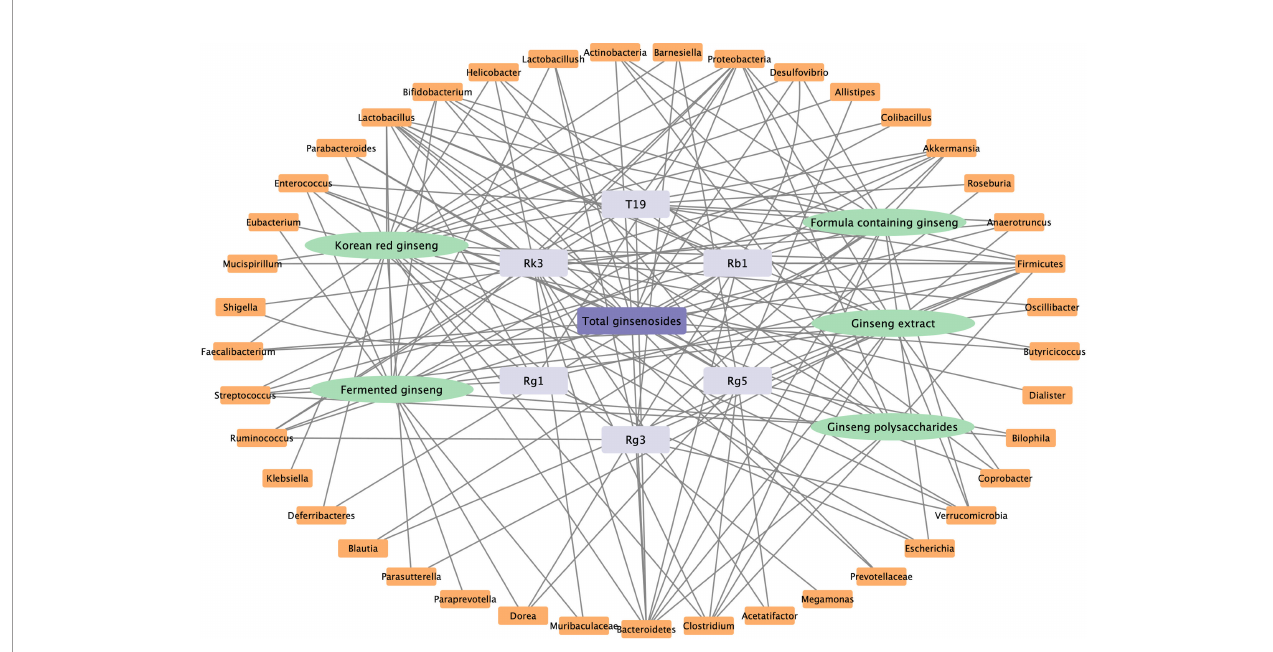
FIGURE 4 | The correlation between ginseng and gut